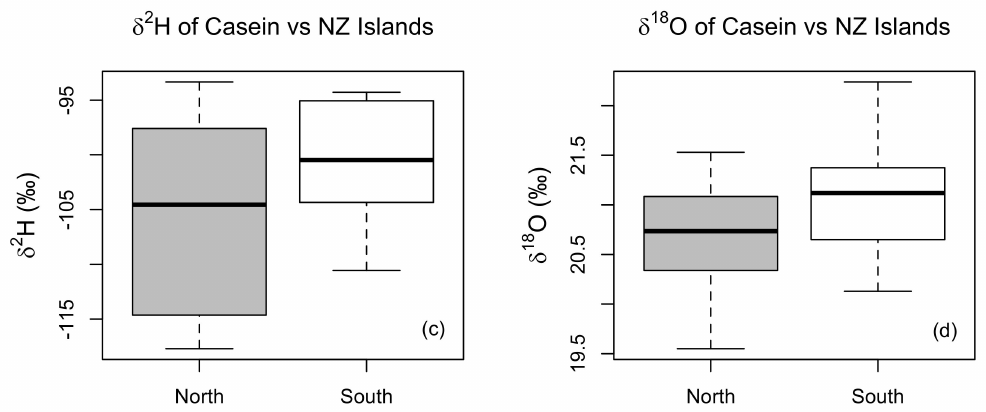
Figure 1. Stable isotopic distribution of casein samples across dairy farms in the North Island and the South Island of New Zealand: ( a ) δ 13 C values of casein vs NZ Islands; ( b ) δ 15 N values of casein vs NZ